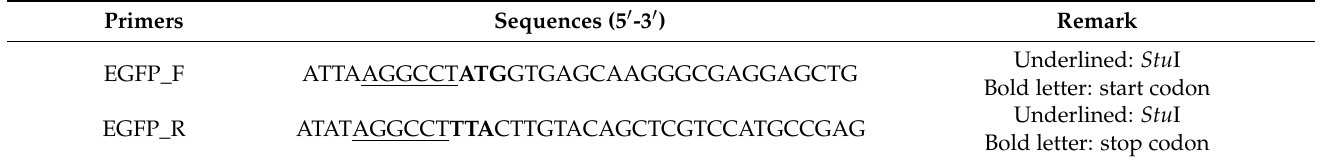
Table 2. Sequences of primers used for cloning a GFP gene into